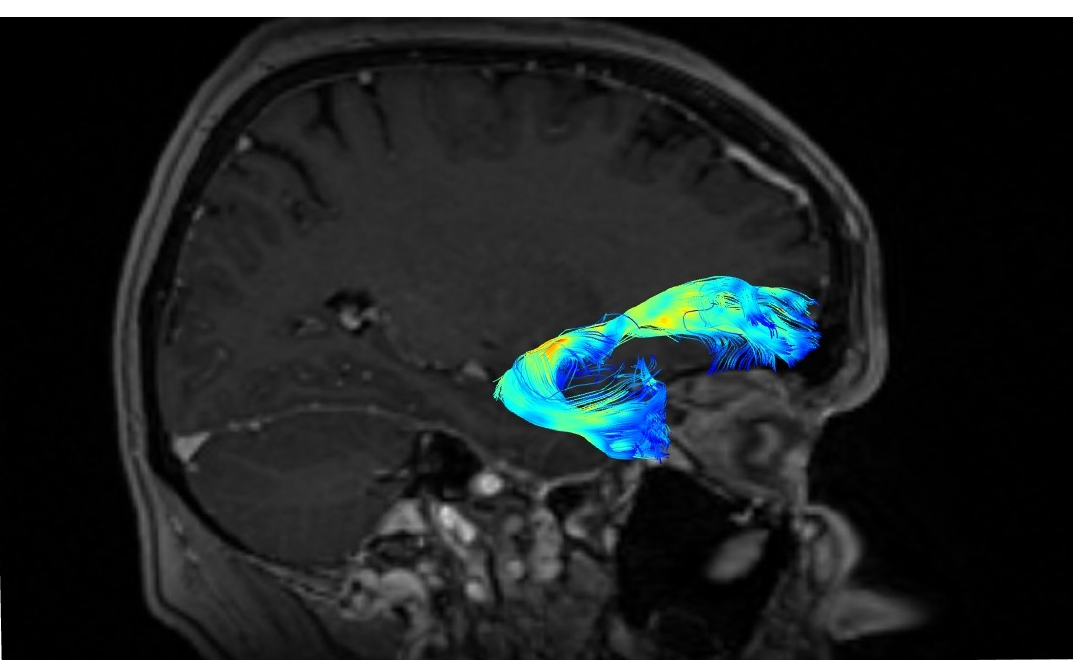
Figure 2. Hook-shape of the uncinate fasciculus (UF).